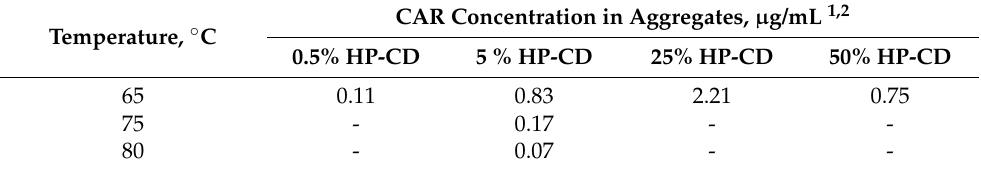
Table 3. The dependence of entrapped CAR content on the reaction temperature and the concentra- tion of